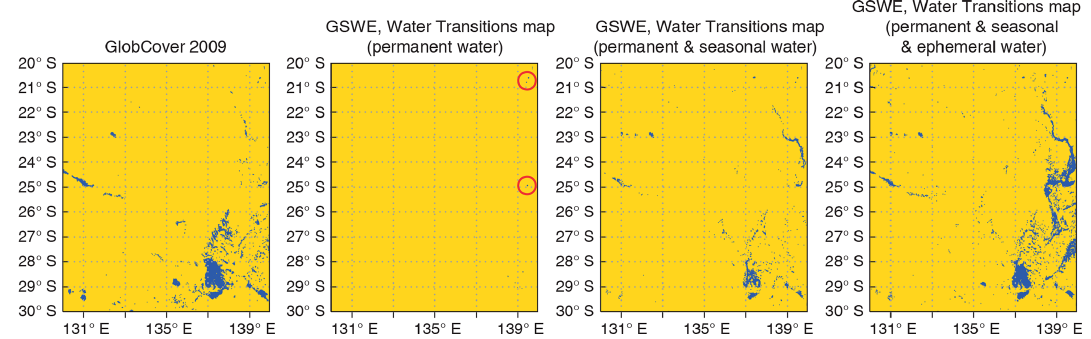
Figure 4. Water distribution for the Australian (20–30 ◦ S, 130–140 ◦ E) region using GlobCover 2009 and the GSWE Water Transition map with different water class combinations; permanent water stands for a combination of the (1) permanent, (2) new permanent and (7) seasonal to permanent water classes; seasonal water – (4) seasonal, (5) new seasonal and (8) permanent to seasonal; ephemeral water – (9) ephemeral permanent and (10) ephemeral seasonal; yellow colour indicates land, dark blue indicates water, and red circles indicate the locations of Lake Moondarra (upper circle) and Lake Machattie (lower circle).